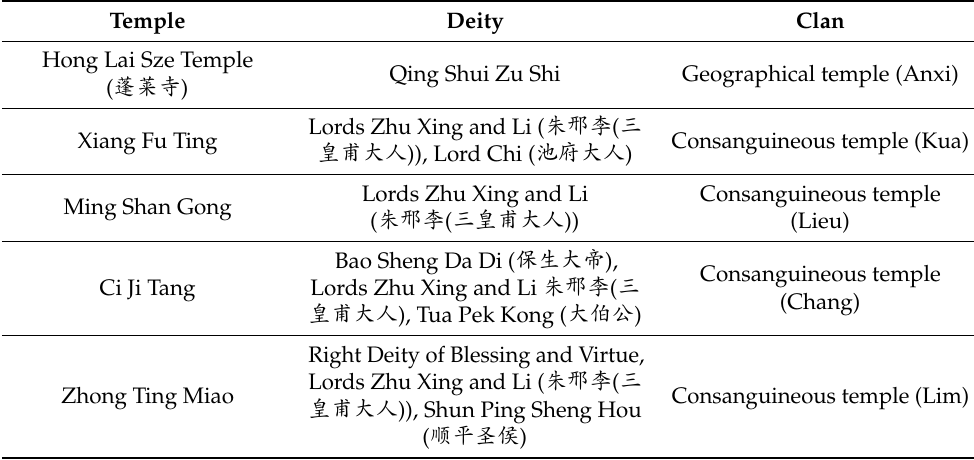
Table 5. The Main Deities Worshipped in Hong Lai Sze United